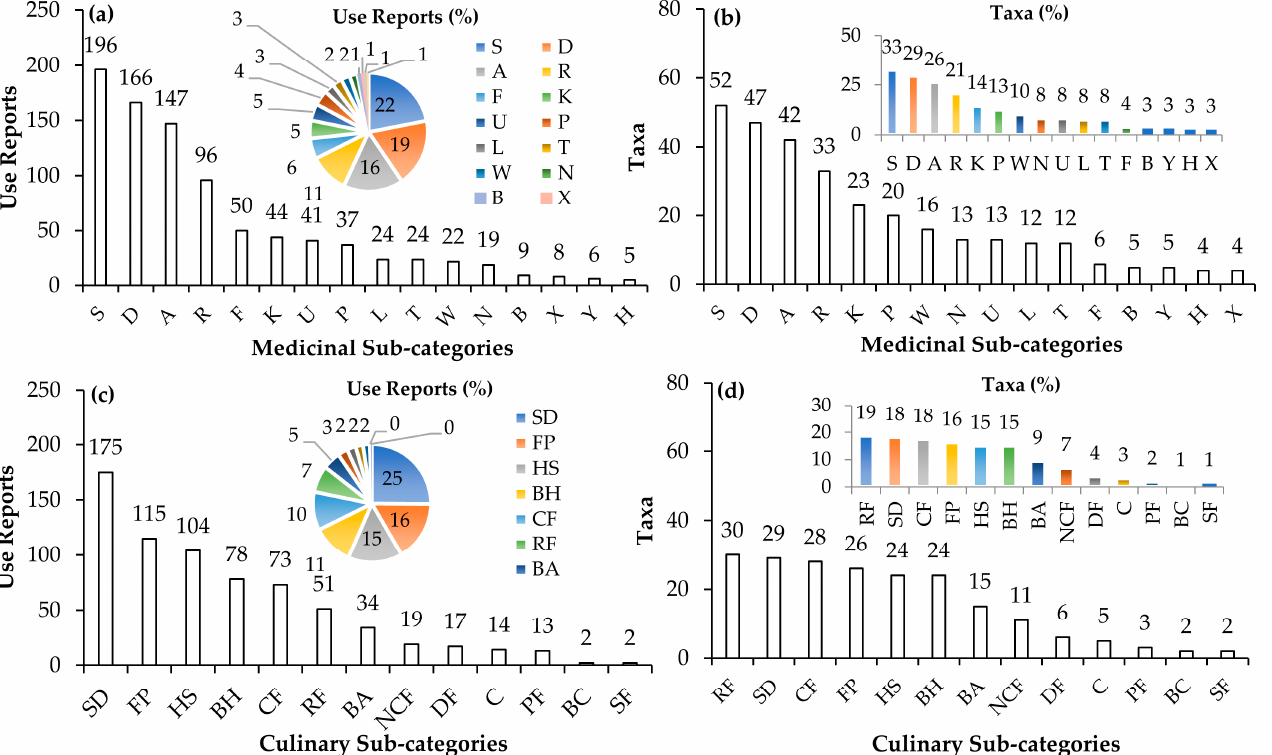
Figure 3. ( a ) The number of use reports (bar chart) and their percentage (pie chart) by medicinal sub-category. ( b ) The number of plant taxa reported (bar chart) and their percentage (colored bar chart) by medicinal sub-category. ( c ) The number of use reports (bar chart) and their percentage (pie chart) by culinary sub-category. ( d ) The number of plant taxa reported (bar chart) and their percentage (colored bar chart) by culinary sub-category. Medicinal sub-categories (according to ICPC-2): skin (S), digestive (D), general and unspecified (A), respiratory (R), eye (F), cardiovascular (K), urological (U), psychological (P), musculoskeletal (L), endocrine/metabolic and nutritional (T), pregnancy, childbearing (W), neurological (N), blood, blood forming organs and immune mechanism